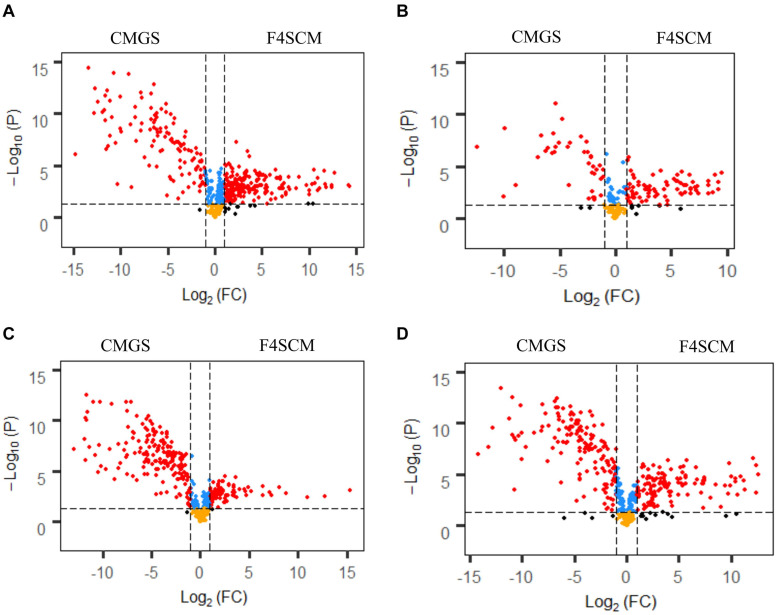
Volcano plots show the relative abundance of metabolite features by combining the statistical t-test [–log10(p-value)] and the magnitude of the change (log2 [FC]) in C18 negative (A), C18 positive (B), HILIC negative (C), and HILIC positive (D) ionization mode datasets. Red dots represent the metabolites with p-value < 0.05 and FC > 2. Blue points represent the metabolites with p < 0.05 and FC < 2. Yellow points represent the metabolites with p-value > 0.05 and FC < 2. Black dots represent the metabolites with p > 0.05 and FC > 2. CMGS (Cooked meat glucose starch media supplemented with 0.0005% yeast extract, 0.1% hemin, and 1% vitamin K), F4SCM (Farm 4 soil conditioned medium).